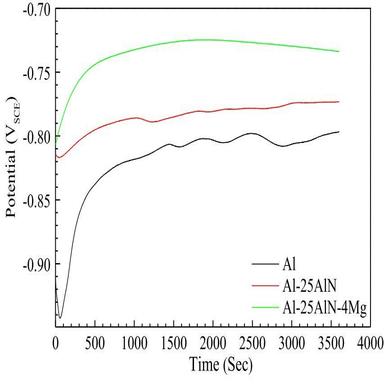
(a) Open circuit potentials and (b) Potentiodynamic polarization curves of alloys in 0.1 M NaCl solution.